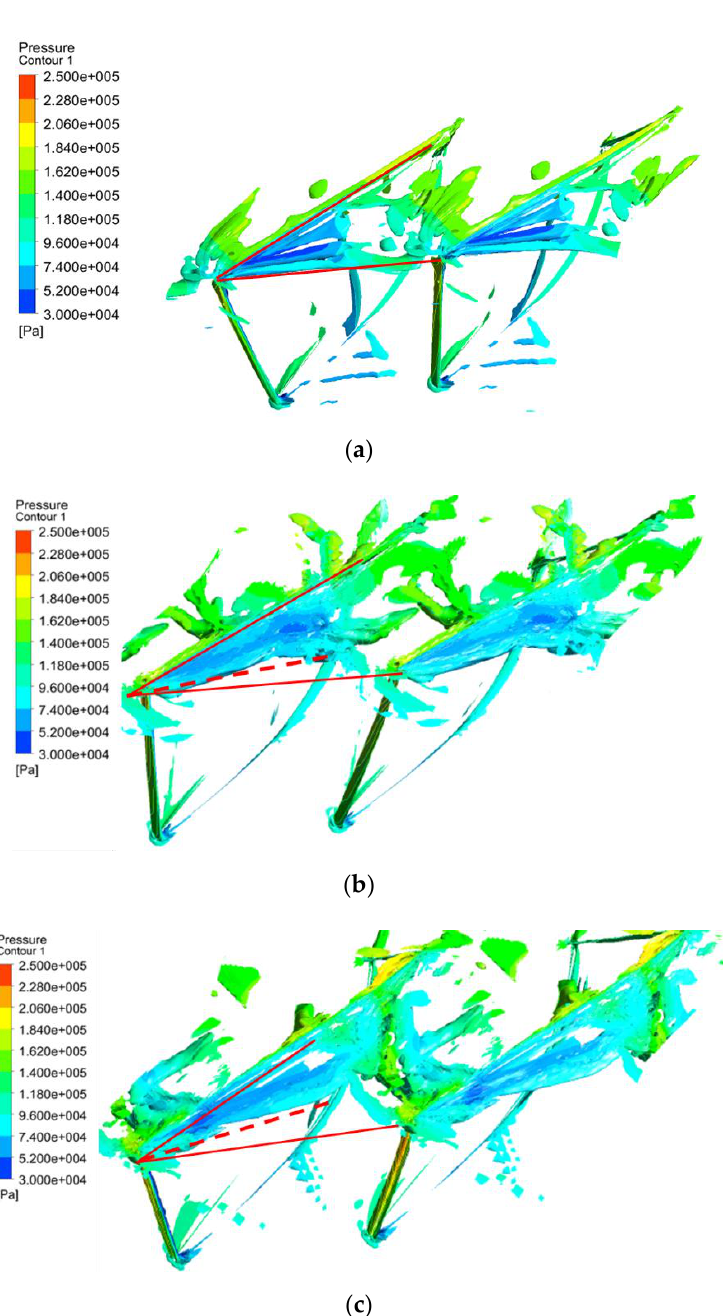
Figure 15. The lambda 2 iso-surface contour of the average pressure in an unsteady period. ( a ) Solid casing; ( b ) 10% axial slots; ( c ) 20% axial slots.